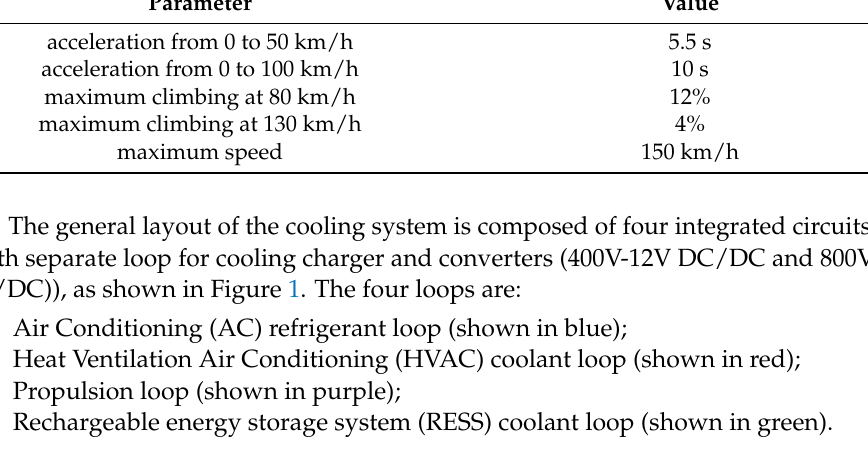
Table 2. Performance requirements of the vehicle.